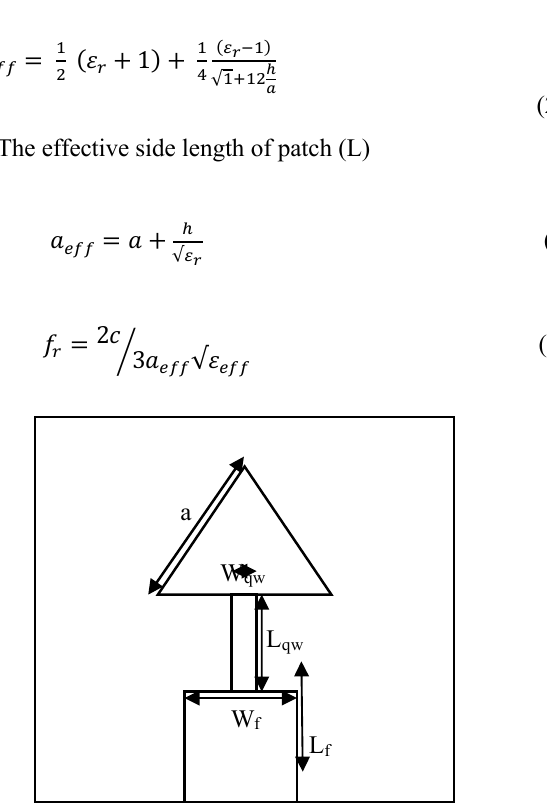
Figure 1: Conventional triangular patch